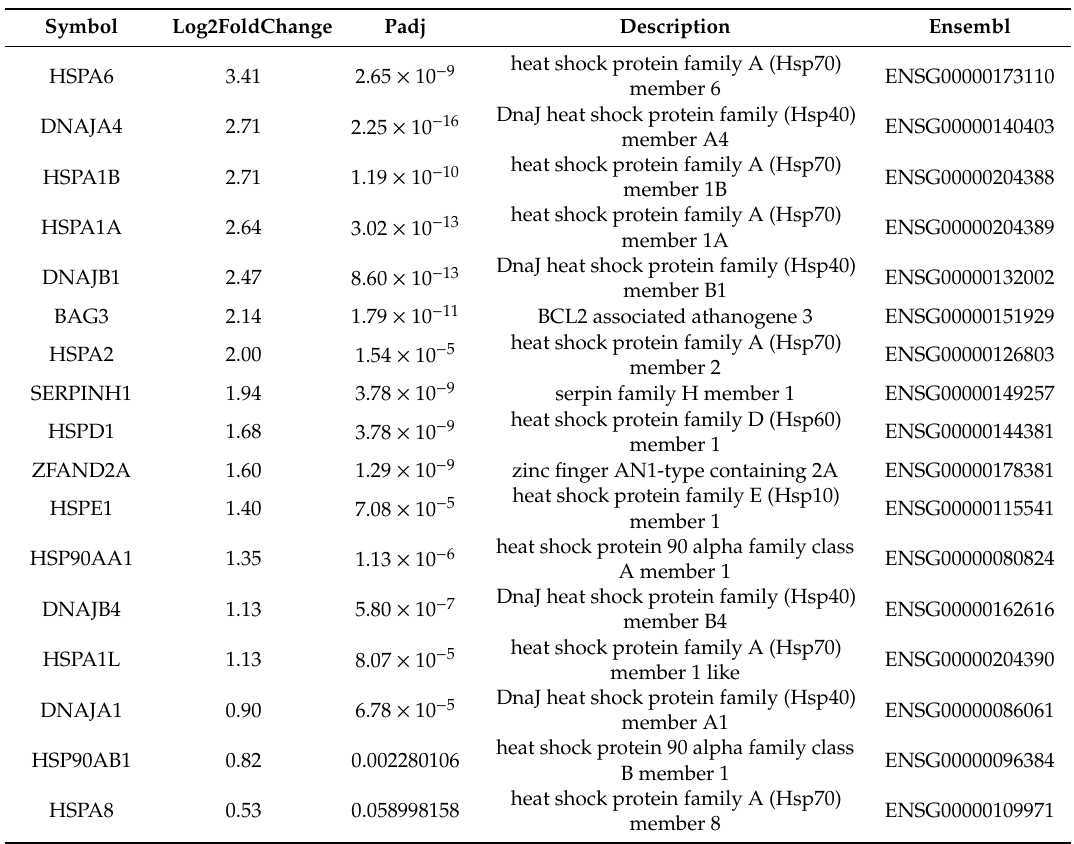
Table 2. Cluster of heat-shock protein DEGs between Myr-treated and untreated CF-patients- derived